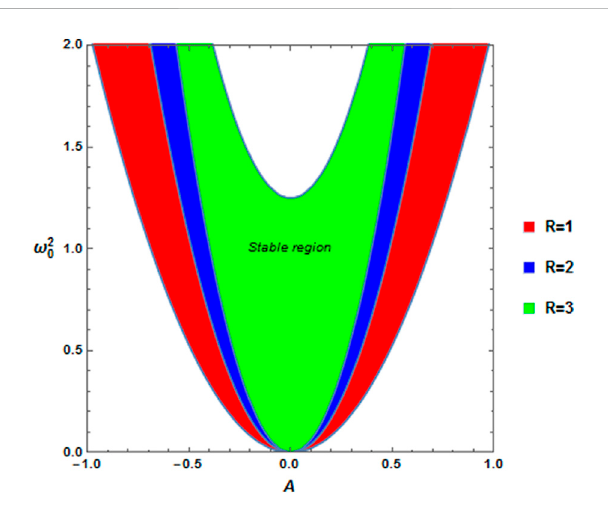
FIGURE 7 Stabilitydistributionofthesamesystem,asgiveninFigure6,except that P (cid:2) 0 . 2.